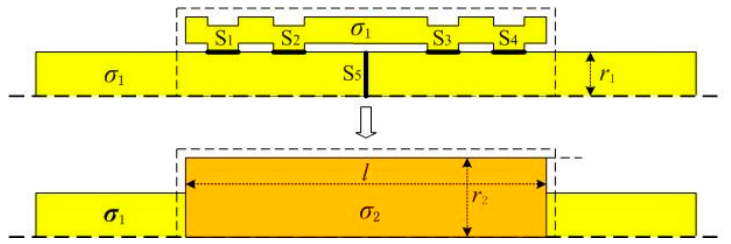
Figure 14. Structure and equivalent model of cable conductor connection.